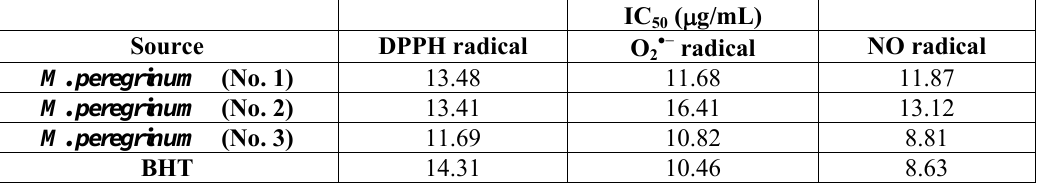
Table 2. IC values ( μ g/mL) of the neutralization of DPPH  , NO  and O 50 Marrubium peregrinum essential oil and BHT (as a positive control).